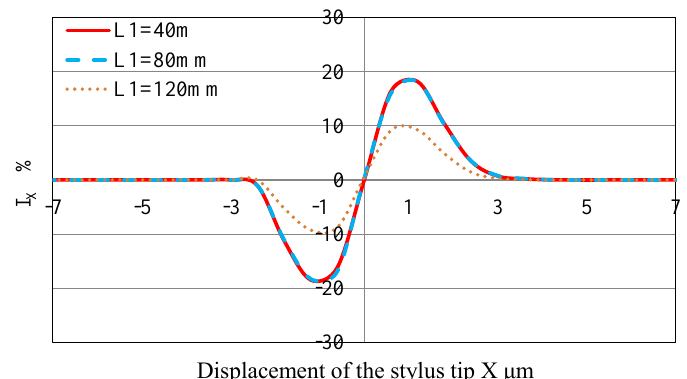
Figure 8. Simulation results for I X for distances L 1 = 40, 80, and 120 mm ( X displacement of the stylus tip = ±7 µm of the stylus).